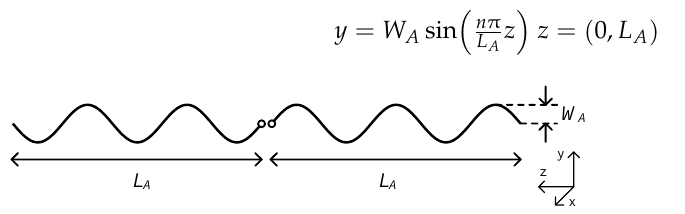
Figure 1. Antenna Geometry with n = 5. Small circles in the middle indicate the feeding point. The antenna is placed along Z -axis, and the peaks and dips are along the Y -axis.